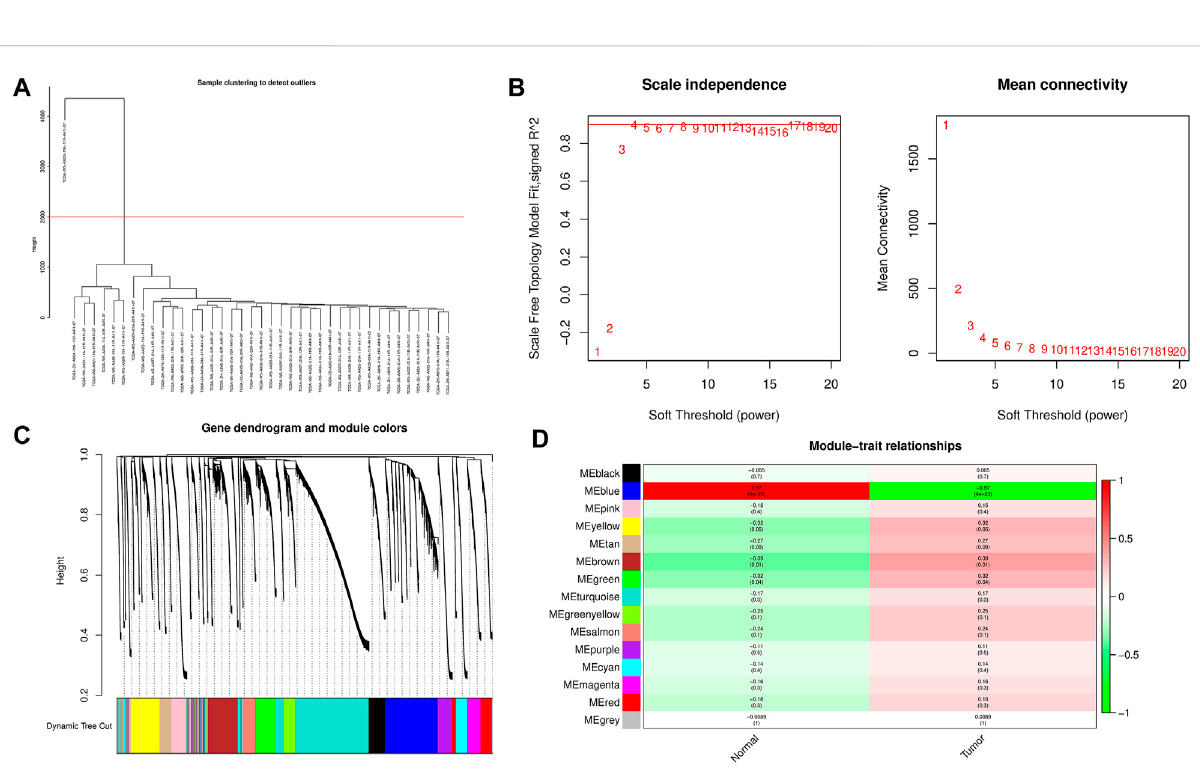
FIGURE 2 Constructionofco-expressionmodulesrelated toiCCA. (A) Settheheightto2000to removeoutliers. (B) Determinethebest softthreshold(In the process of module selection, the adjacency matrix is converted into a topology matrix, and the optimal soft threshold β = 4 is determined). (C) Cluster tree of coexpressed gene modules (D) The correlation between the gene module and clinical information (The redder the color, the higher the correlation; the fi gure in the fi gure is the Pearson correlation coef fi cient, in brackets. The number is the corresponding p